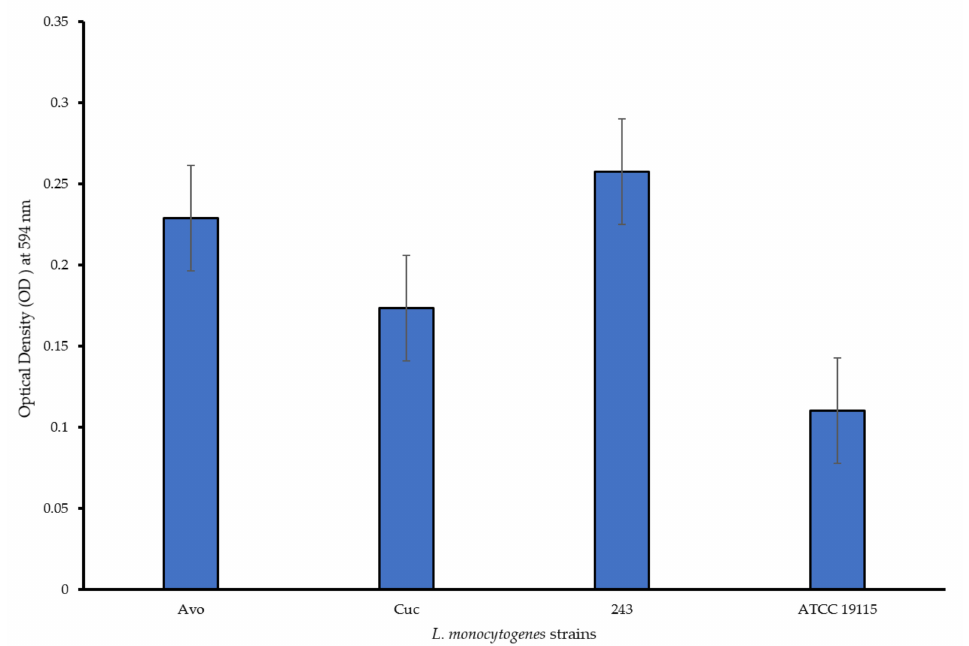
Figure 1. Biofilm formation capabilities of the test L . monocytogenes strains in PVC microtiter